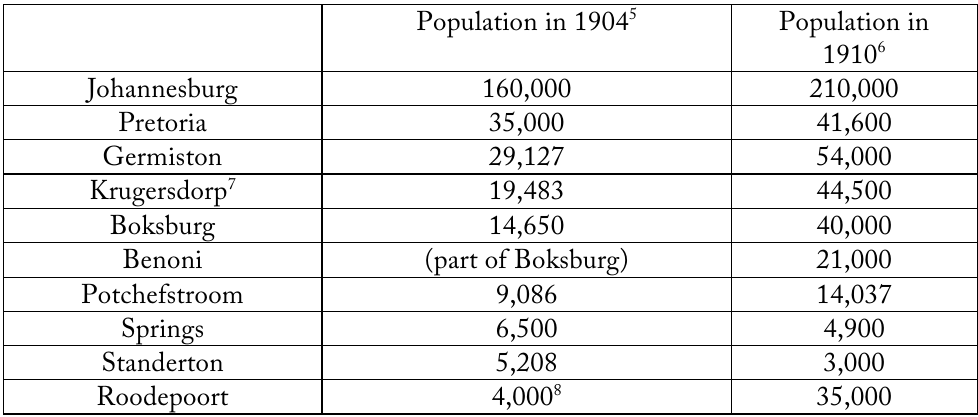
Table 1. Most populous municipalities in the Transvaal in 1904 and 1910 Population in 1904 5 Population